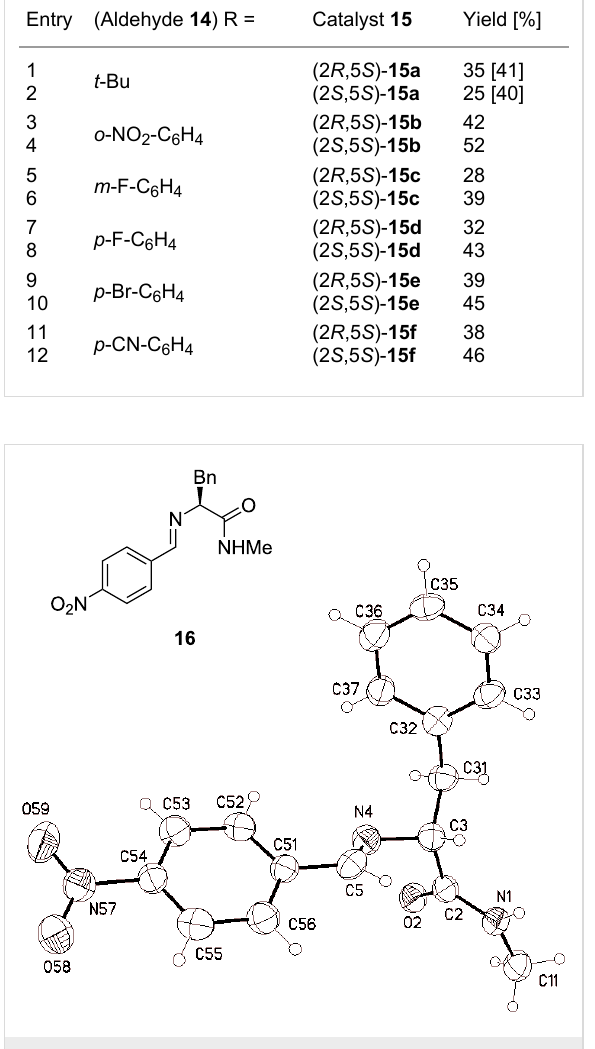
Figure 4: Crystal structure of the side product from the reaction of 13 .